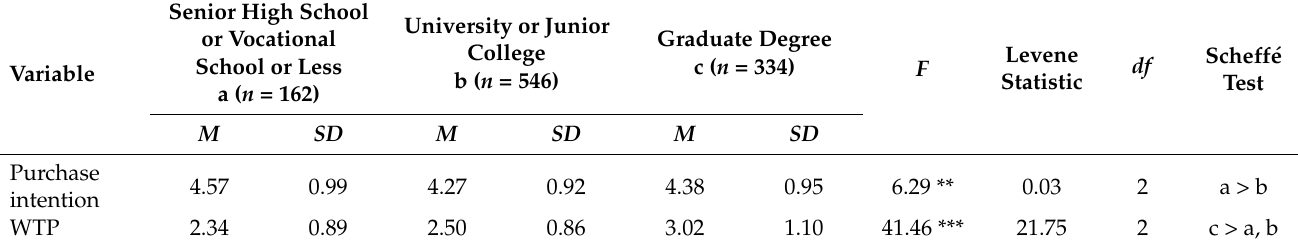
Table 6. One-way ANOVA for educational level ( n = 1042).